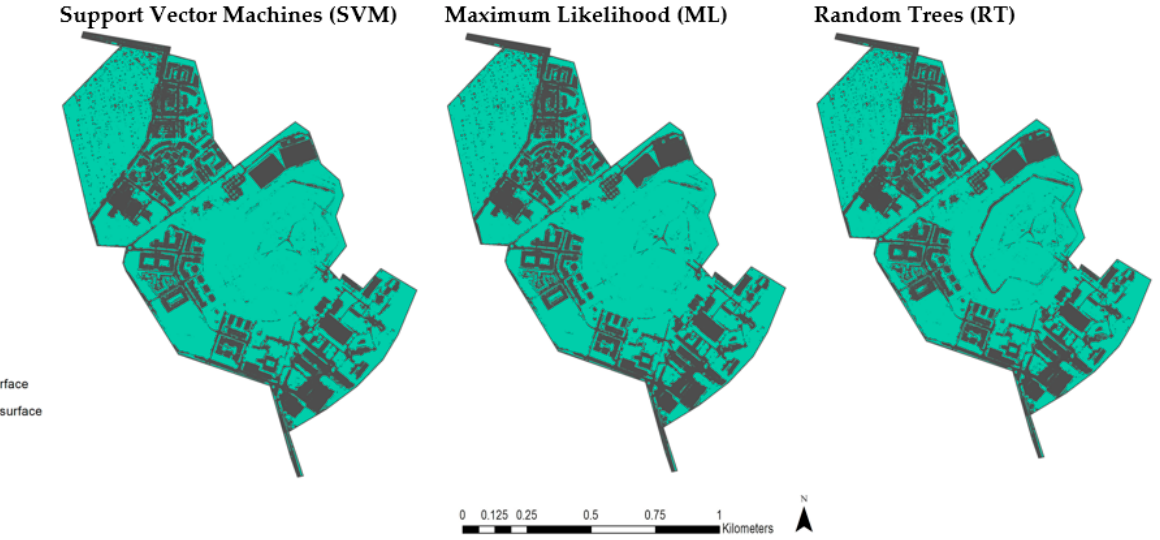
Figure 6. Land Use/Land Cover (LULC) classification using SVM, ML and RT methods. (Source: own elaboration based on orthophoto maps available on Geoportal—https://www.geoportal.gov.pl/, accessed on 2 November 2022).